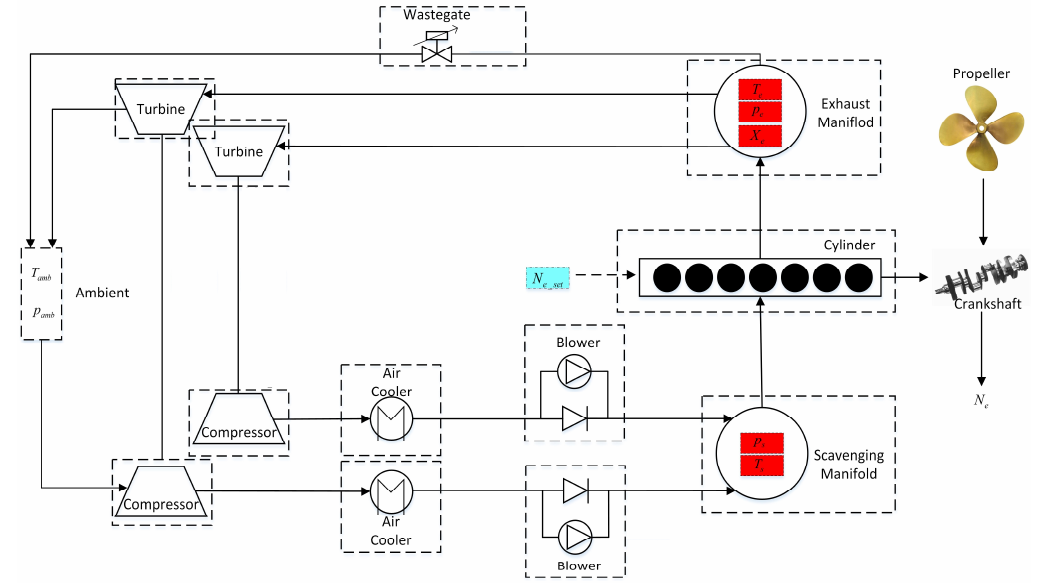
Figure 1. Mean value engine model (MVEM) structure. Table 1. Main Technical parameters of 7S80ME-C9.2 diesel engine at MCR (Maximum Continuous Rating).